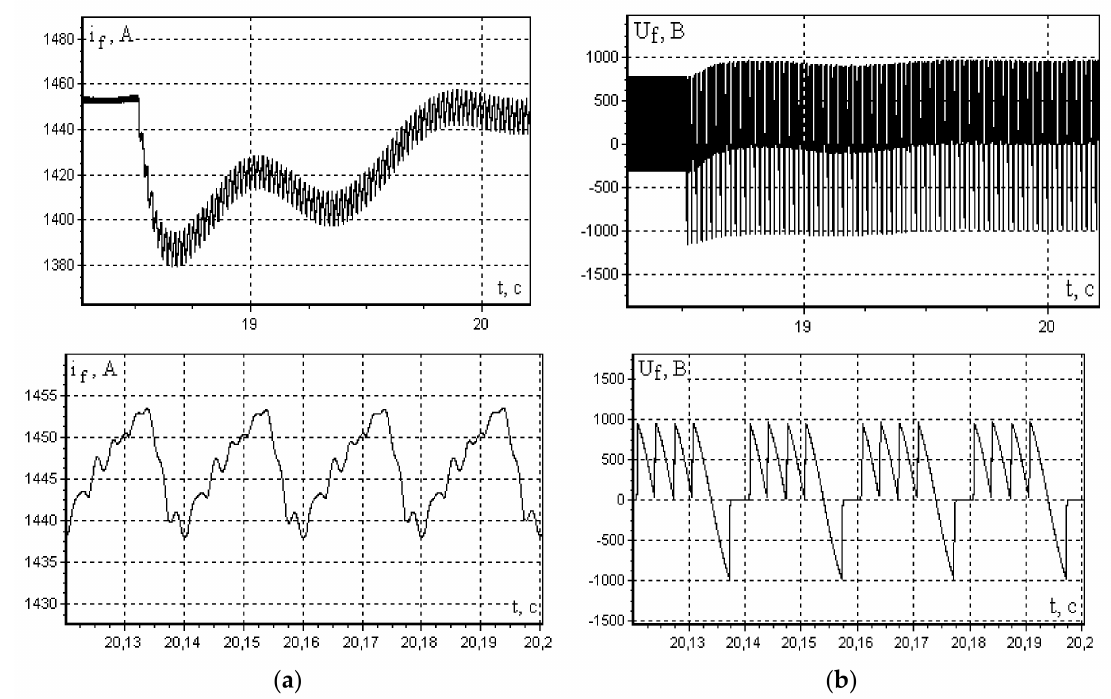
Figure 11. ( a ) Field voltage ( u f ); ( b ) field current of the generator ( i f ) in the case of a thyristor fault (i.e., when the thyristor does not turn